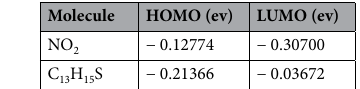
Table 1. Orbital energy of each state front.